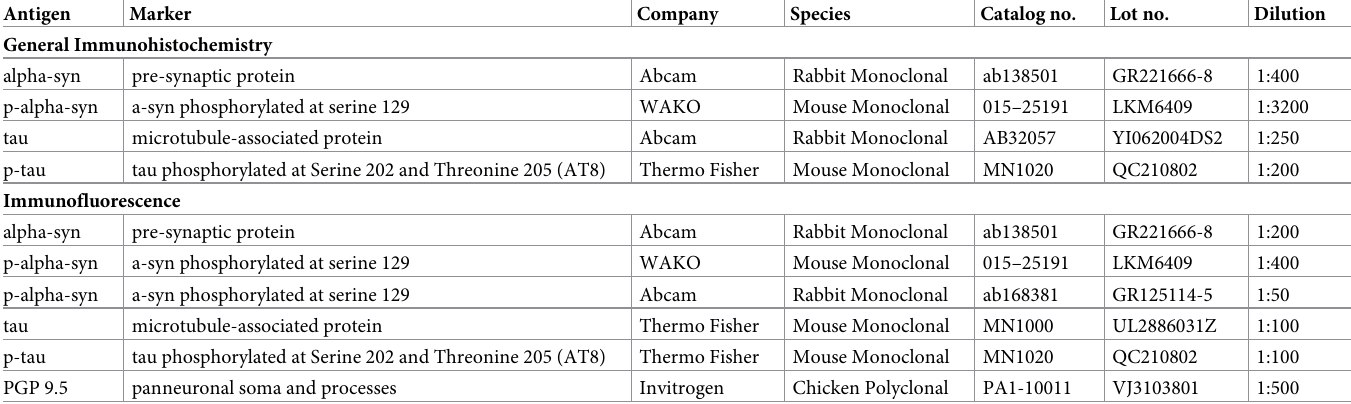
Table 2. Antibody information used in general immunohistochemistry and immunofluorescence